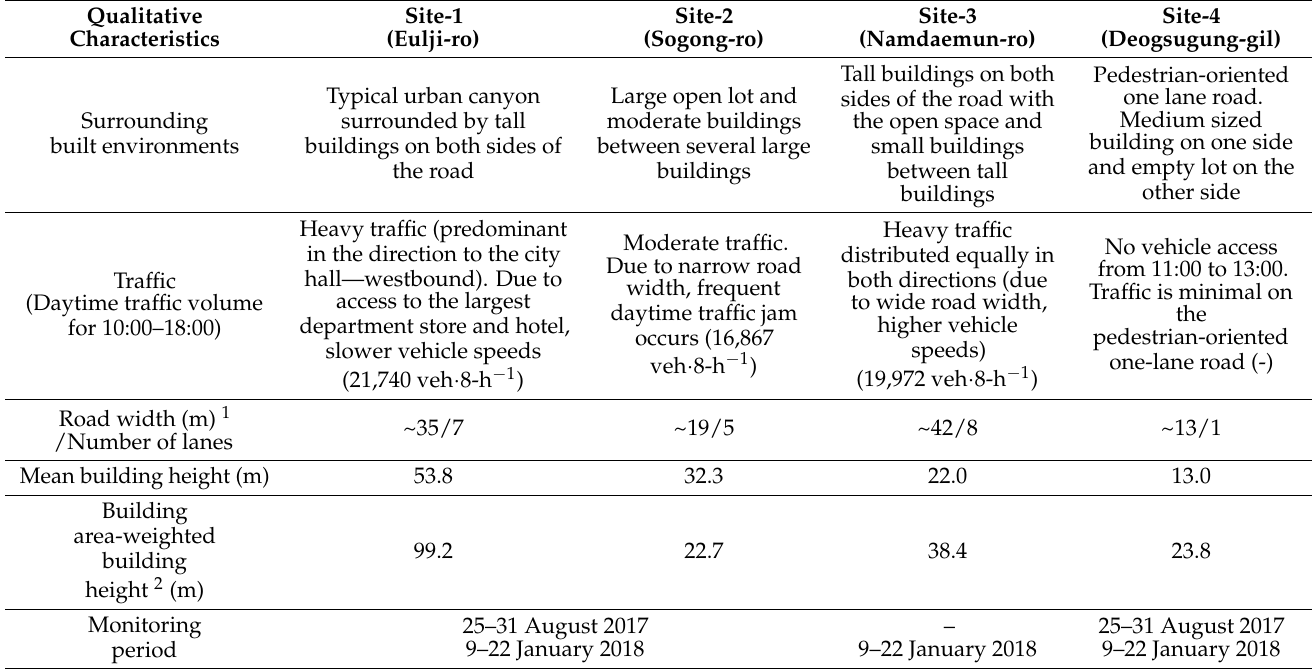
Table 1. Characteristics of the traffic flows and built environments of the monitoring sub-sites. Qualitative